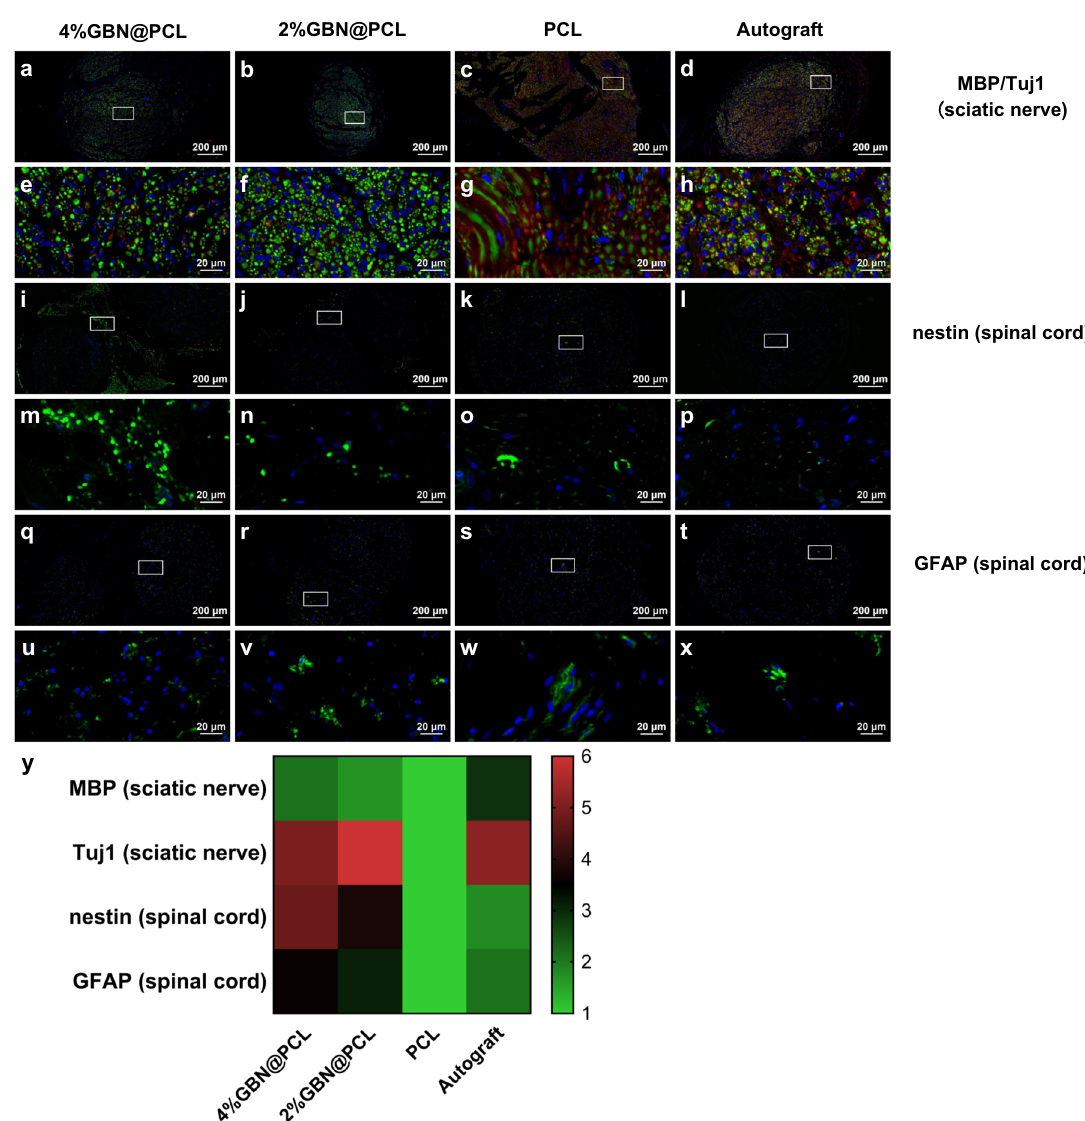
Fig. 3 Glial and neural expression of peripheral nerves and spinal cords by GBN. MBP/Tuj1 triple immunostaining of the regenerated sciatic nerve sections ( a – h ). Red fl uorescence, MBP; Green fl uorescence, Tuj1; Blue fl uorescence, nuclei. Nestin ( i – p ) and GFAP ( q – x ) immunostaining of the spinal cord. Green fl uorescence, Nestin/GFAP; Blue fl uorescence, nuclei. Relative expression levels of MBP and Tuj1 of the sciatic nerves, and nestin and GFAP of the spinal cord ( y